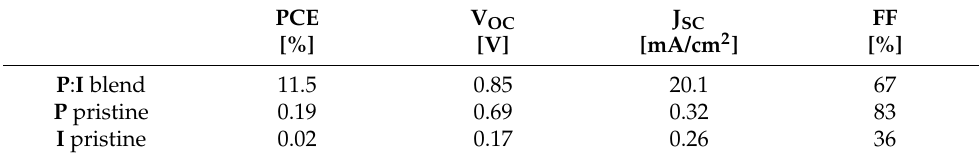
Table 1. Overview of device